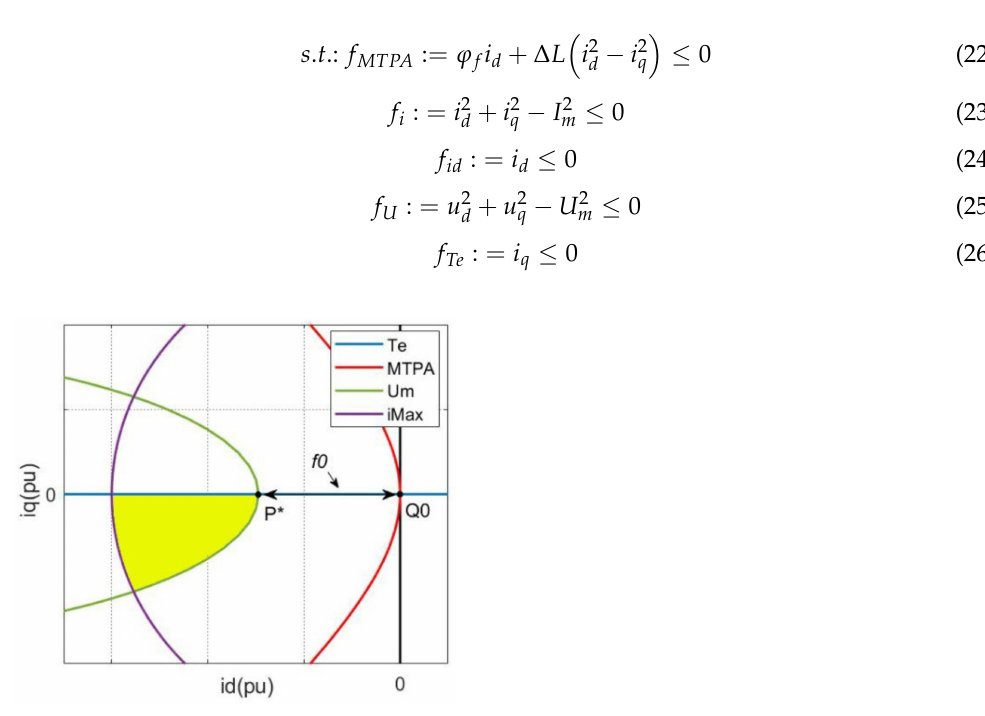
Figure 6. Equivalent optimization problem, TeR =